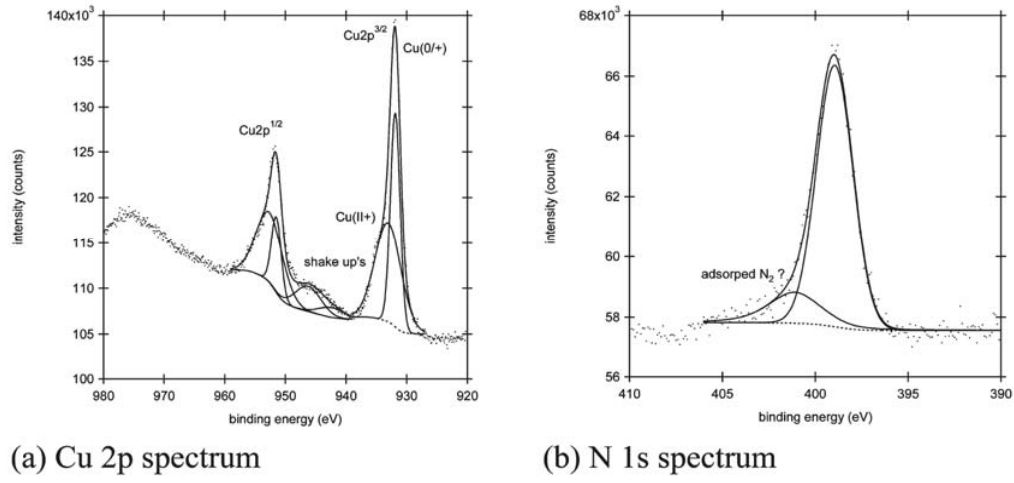
Figure 5. X-ray photoelectron spectra of ( a ) Cu 2p and ( b ) N 1s regions of a monolayer